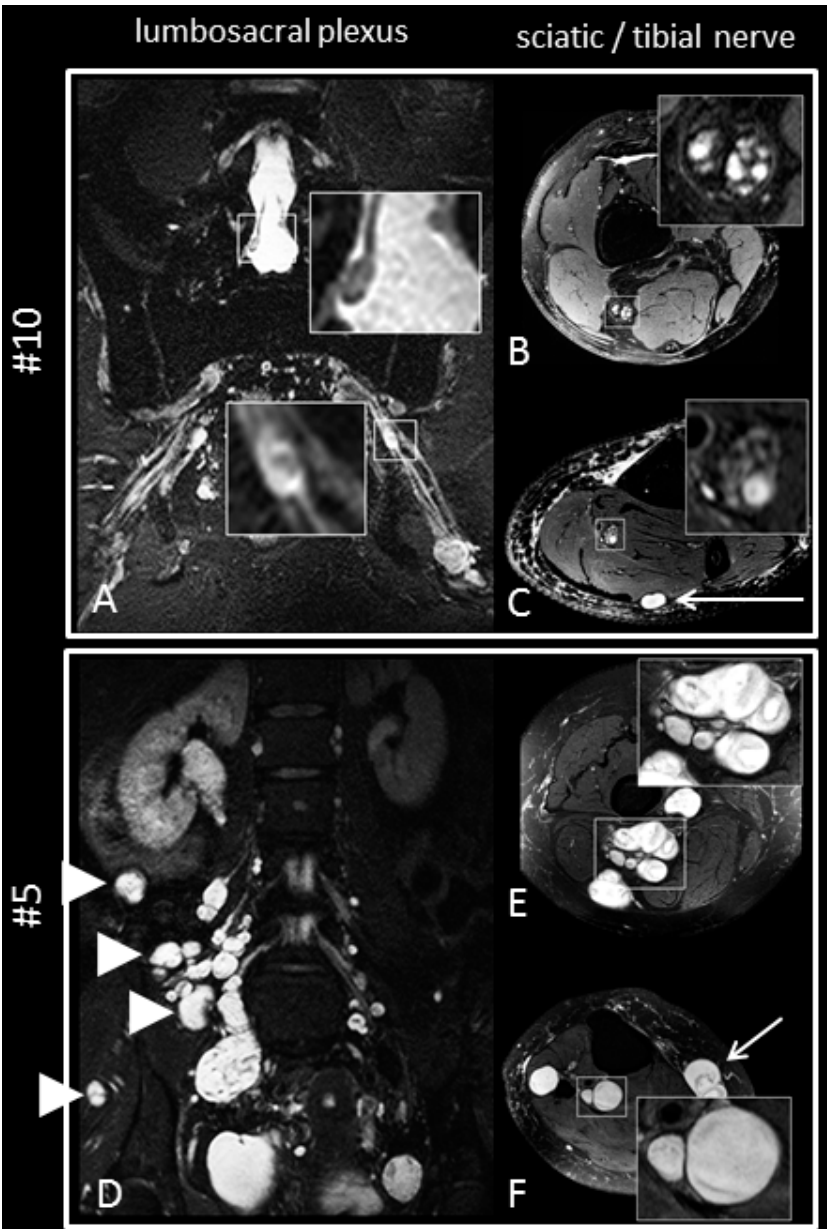
Figure 3. Exemplary cases of severe schwannomatosis imaging findings. The upper panel shows representative images of patient #10 with a high extent of nerve abnormalities (overall MRN lesion burden score 3). Schwannomas of the cauda equina ( A , upper inset) and the sciatic nerve trunk ( A , lower inset) are shown in magnification. Sciatic and tibial nerves have enlargement of individual fascicles ( B and C ). Lower panel shows patient with ubiquitous severe enlargement of all nerve structures (overall MRN score 4). All plexus elements as well as small intramuscular nerve branches are enlarged ( D ). Sciatic and tibial nerve ( E and F , insets) are likewise transformed into masses affecting all nerve fascicles. Smaller nerves such as the saphenous nerve and sural nerve ( C and F , arrows) as well as smaller muscular branches are clearly visible as schwannoma masses .